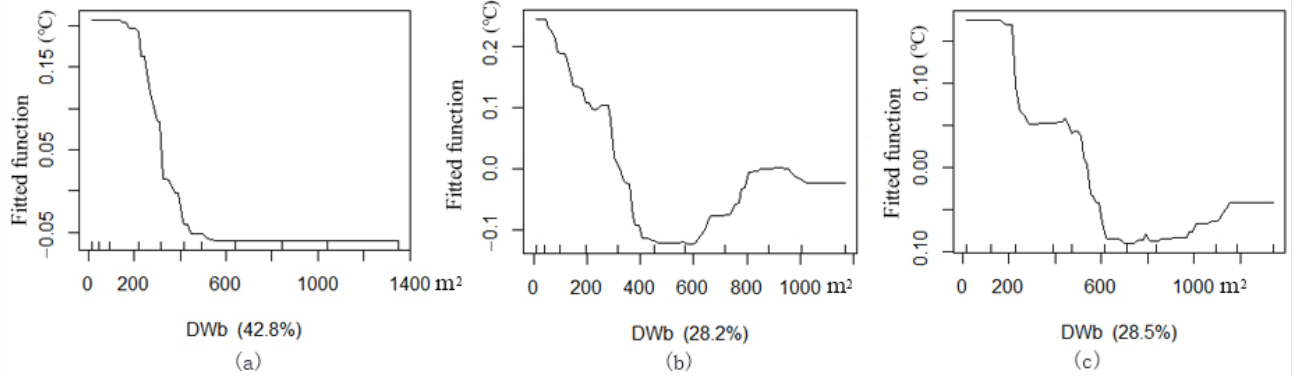
Figure 6. Marginal effect (ME) curve via boosted regression tree (BRT) between the distance from the water body (D) and T values of green corridors: ( a ) block N1, ( b ) block N2 and ( c ) block N3.